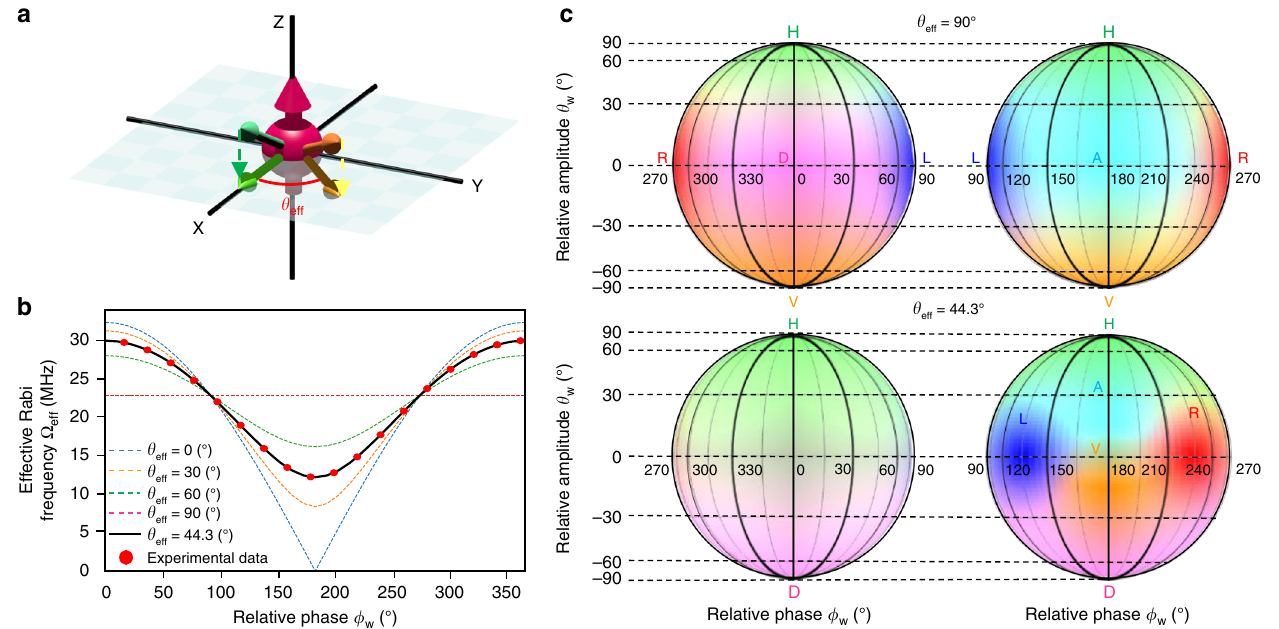
Fig. 5 Calibration of the microwave polarisation. a Spatial arrangement of the fi eld vectors of the microwaves generated from two wires and those projected in the plane normal to the NV axis ( z -axis) angled by θ eff . The projected fi eld vector generated by wire 1 de fi nes the x axis. b The dependence of effective Rabi frequency Ω eff on the relative phase ϕ w = ϕ 2 − ϕ 1 for various θ eff . We tuned the microwave amplitude to Ω 1 = Ω 2 = 16.13 (MHz) to see the ϕ Ω θ = 44.3°. c Mapping from the Bloch sphere spanned by the microwaves generated by the (cid:7) (cid:8) w dependence of the eff . The experimental results indicate eff ¼ 2 arctan ð Ω (cid:2) Ω Þ = ð Ω þ Ω Þð Þ ; ϕ ¼ ϕ (cid:2) ϕ two wires parameterised by θ to the achieved polarisations. The upper two spheres show the ideal 1 2 1 2 2 1 w w case (effective wire angle θ eff = 90°), and the lower two spheres show the realistic case in our experimental case ( θ eff = 44.3°). Even when